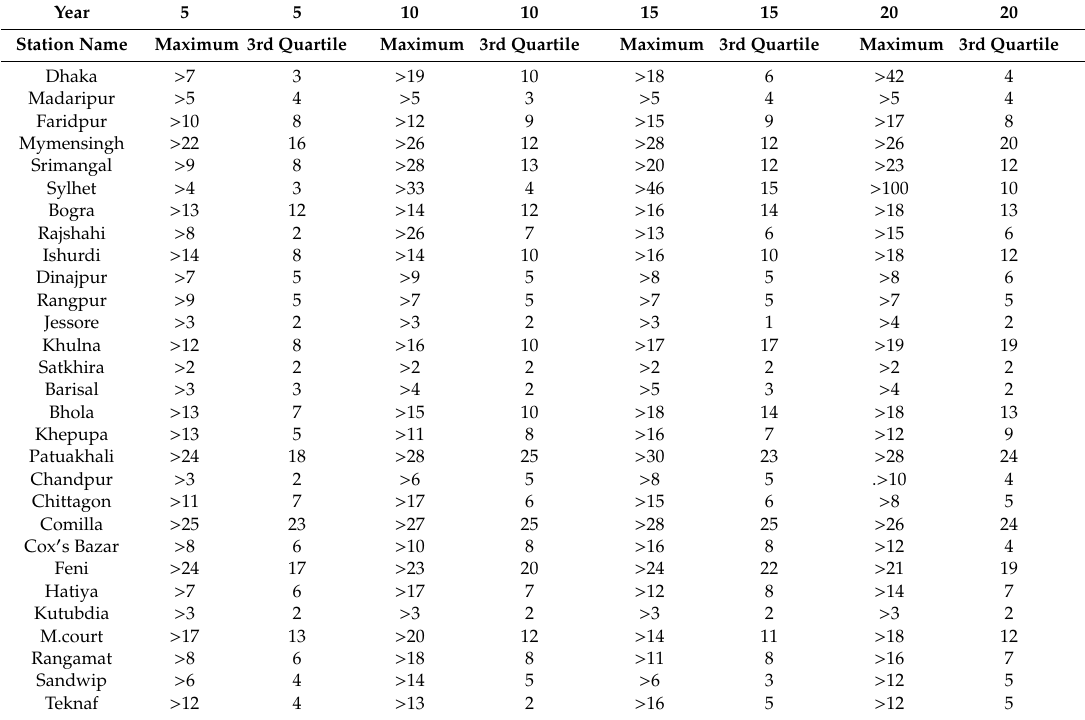
Table A2. Probability of maximum number of TS days for di ff erent periods at di ff erent locations of